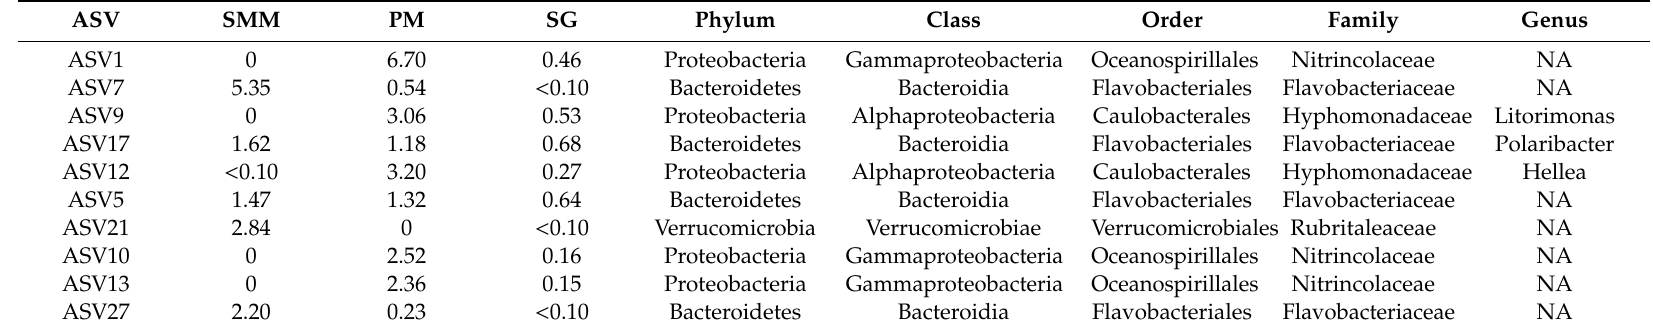
Table 2. Abundance percentage and taxonomic a ffi liations of the 10 most abundant ASVs (amplicon sequence variant) of LV sampling sites (total of all sampling